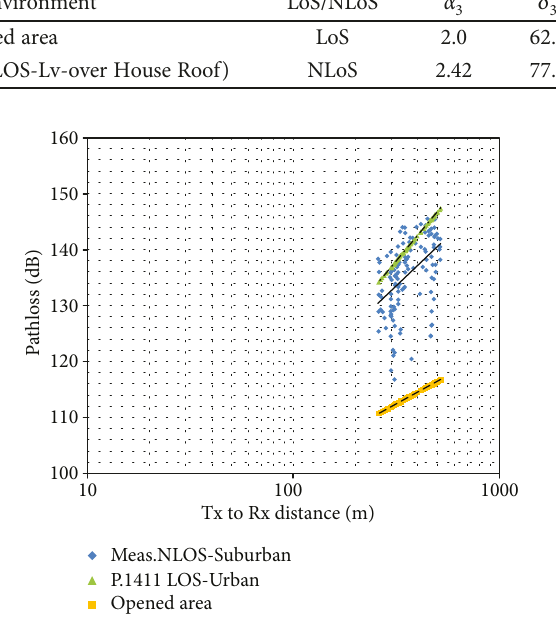
Figure 14: Pathloss characteristics according to the distance in NLoS environment (at